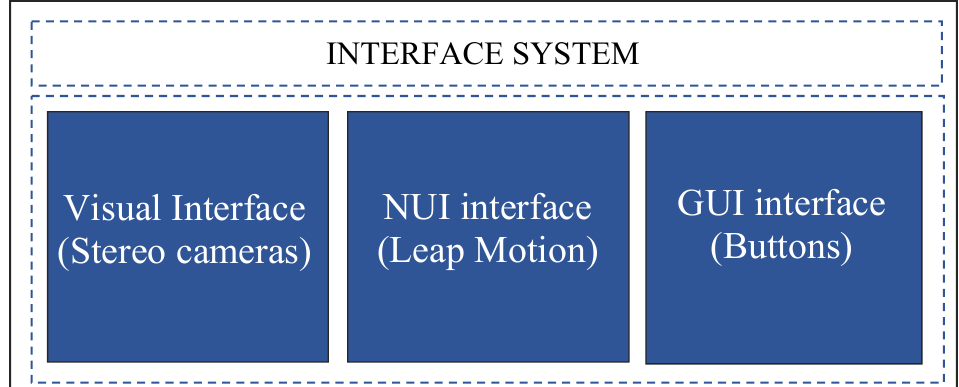
Figure 1. Proposed interfaces for human–robot interaction.